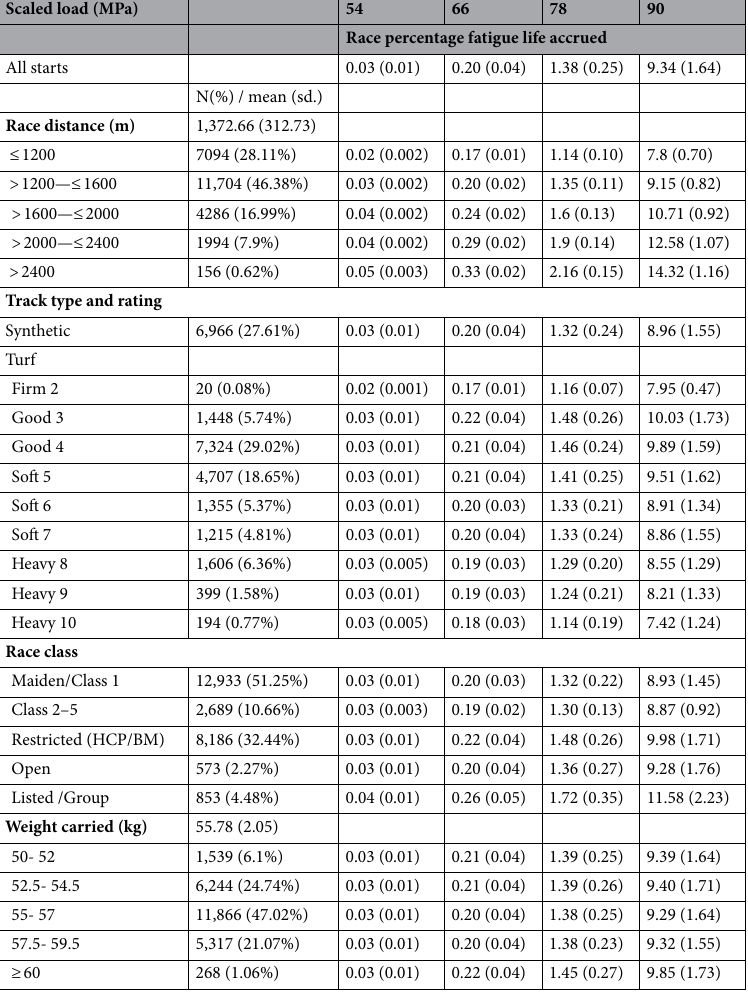
Univariable regression results for the horse- and race-level factors predicting the percentage fatigue life accrued per race start scaled to 90 MPa joint force loading are presented in Supplementary Table S1. In multi- variable analysis, horse-level factors of age and sex were associated with the percentage of fatigue life accrued, with more fatigue life accrued per race as age of horse increased, and lower proportion of fatigue life accrued for male horses than females, Table 2. Greater race distances were associated with greater percentage of fatigue life accumulated in a non-linear fashion ( p < 0.001), therefore doubling the distance raced did not equate to double the percentage fatigue life accrued, Fig. 2. Firmer (Good rated) track surfaces were associated with greater fatigue life accrued ( p < 0.001), Fig. 3. The estimated fatigue life accrual for synthetic tracks was between a turf condition of soft 5 and 6, Fig. 3 (statistically different from all turf condition categories; p < 0.001). Better finishing posi- tions were associated with a greater percentage of fatigue life accumulated ( p < 0.001). An interaction was present between weight carried and race class, whereby lower class and restricted races maintained the percentage of fatigue life accrued as weight carried increased. There was some reduction in race percentage fatigue life for high class races (Listed/Group races) as weight increased, but for open class races (races with no special conditions or restrictions), the greater the weight carried the higher the race percentage fatigue life (Fig. 4), however there was only a small number of open class race starters carrying 60 kgs or more (n = 19 of the total 238 race starts carrying this weight). This class of race is available to horses of all abilities (i.e. races with the greatest variation in horse ability).